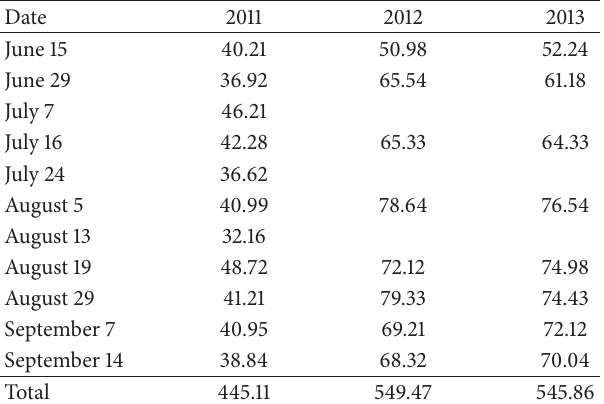
Table 1: Detailed irrigation amount and its distribution